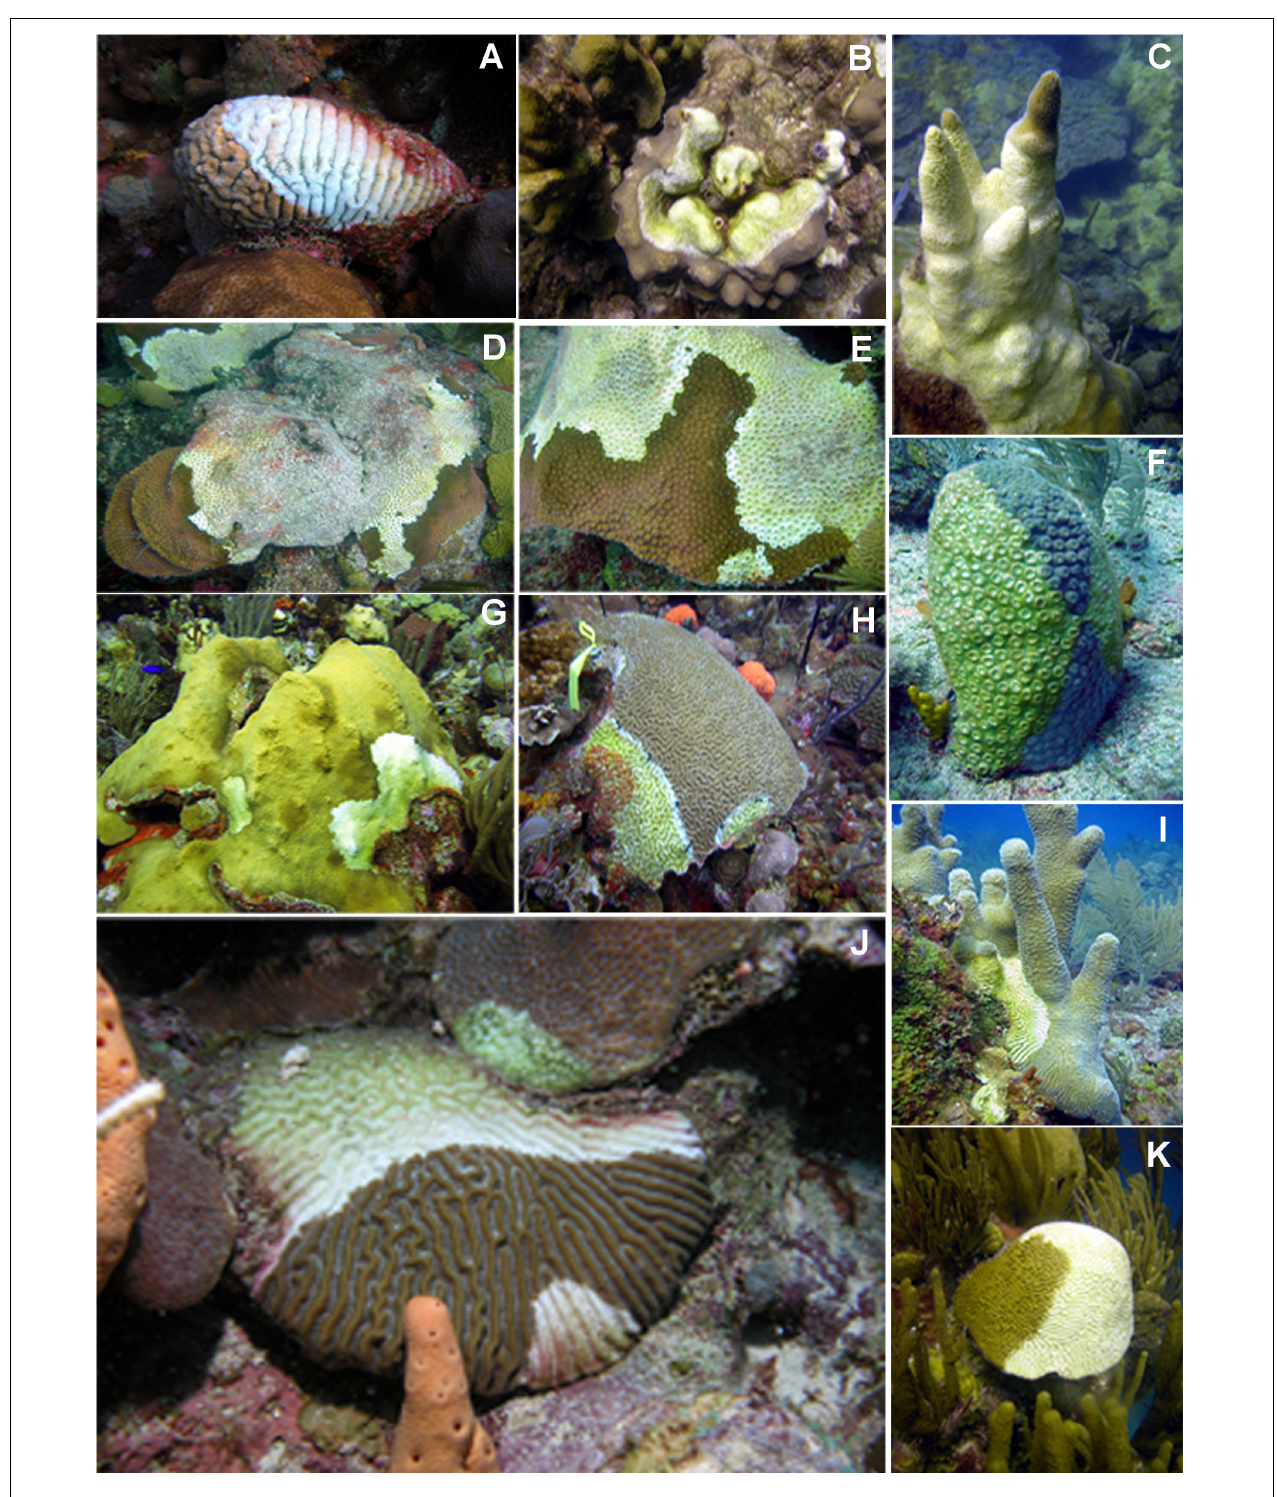
FIGURE 4 | Photos showing colonies of reef-building coral species with WPD-II between 2004 and 2007 in different localities of the Caribbean. Cases having multifocal and focal lesions which not always started from the base of the colony. (A) Meandrina meandrites with fast moving WPD-II in La Parguera in 2005; (B) Orbicella faveolata in Mona Island in 2004; (C) Dendrogyra cylindrus with virulent WPD-II in Curacao in 2005; (D) Montastraea cavernosa in Desecheo in 2005; (E) M. cavernosa with two focal infections and (F) fast mortality in Bermuda in 2005; (G) O. faveolata in La Parguera in 2006. (H) Colpophyllia natans with two focal infections in La Parguera in 2006; (I) D. cylindrus with virulent WPD-II infection in Cayman Islands in 2005; (J) Pseudodiploria strigosa with two WPD-II fast advancing infections and contagion to O. franksi in La Parguera 2006: (K) ; P. strigosa with a highly virulent WPD-II in Bermuda in 2005. Photos E. Weil.